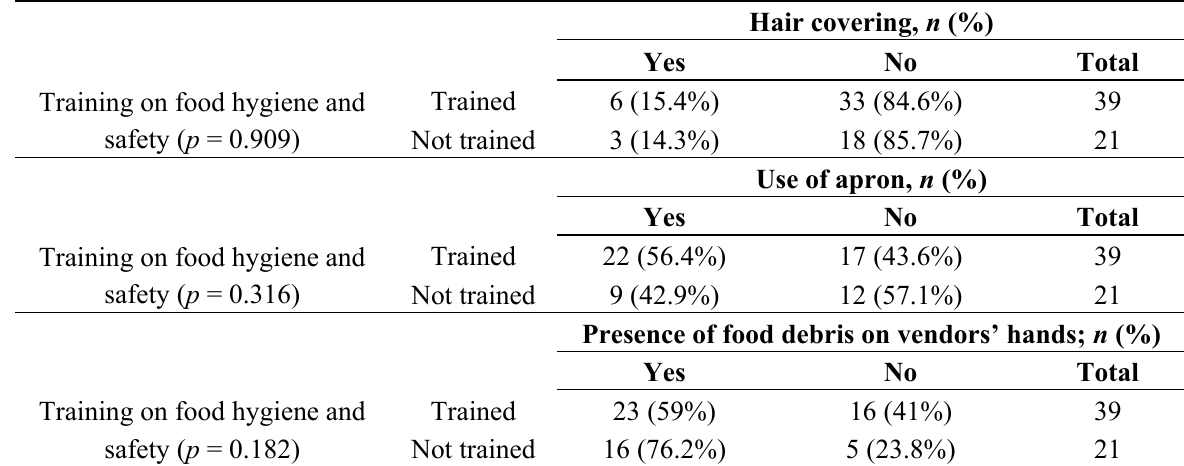
Table 7. Relationship between training on food hygiene and safety, hair protection, use of apron and accumulation of food debris on vendors’